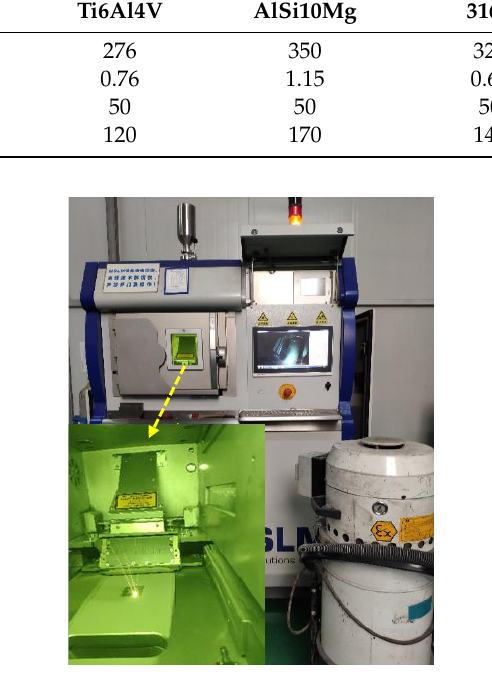
Figure 2. Experimental setup.